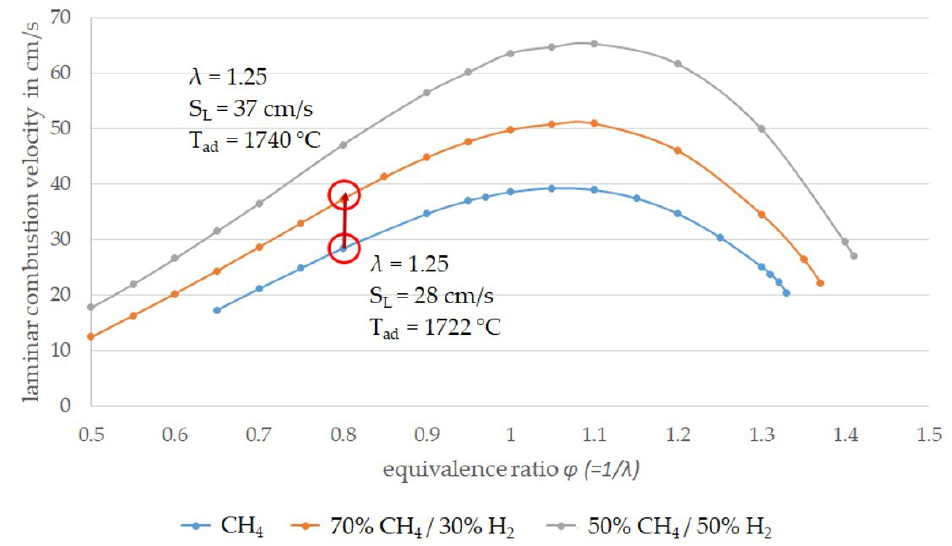
Figure 6. Effects of 30 vol.% H 2 admixture on laminar combustion velocity and adiabatic combustion temperature for an appliance with combustion